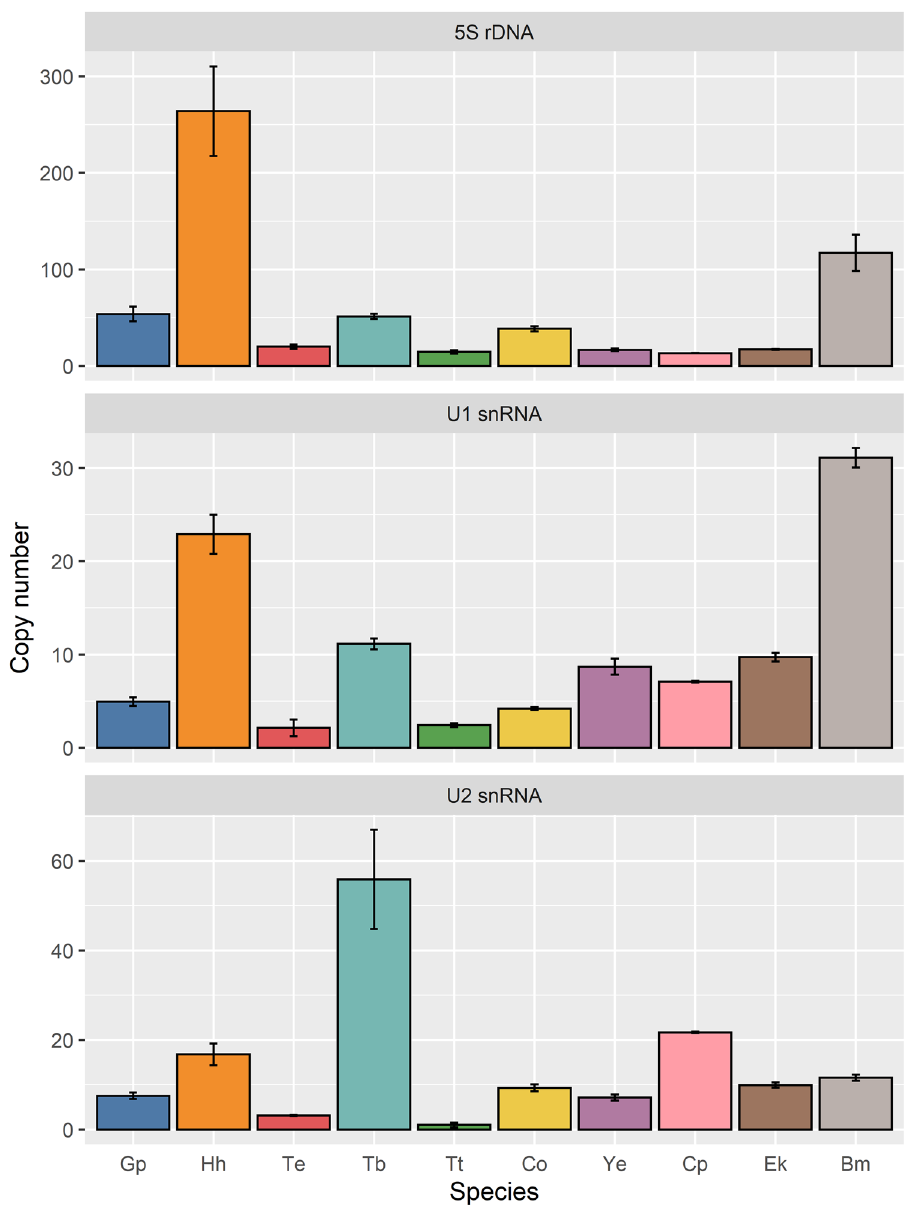
Figure 2. Estimated copy numbers of 5S rDNA, U1 snRNA, and U2 snRNA genes per haploid genome in selected species. Gp, G. pellucidus (Trichoptera, outgroup); Hh, H. humuli ; Te , T. ekebladella ; Tb, T. bisselliella ; Tt, T. tubulosa ; Co, C. ohridella ; Ye, Y. evonymella ; Cp, C. pomonella ; Ek, E. kuehniella ; Bm, B. mori . For a summary of the qPCR results, see Supplementary Table